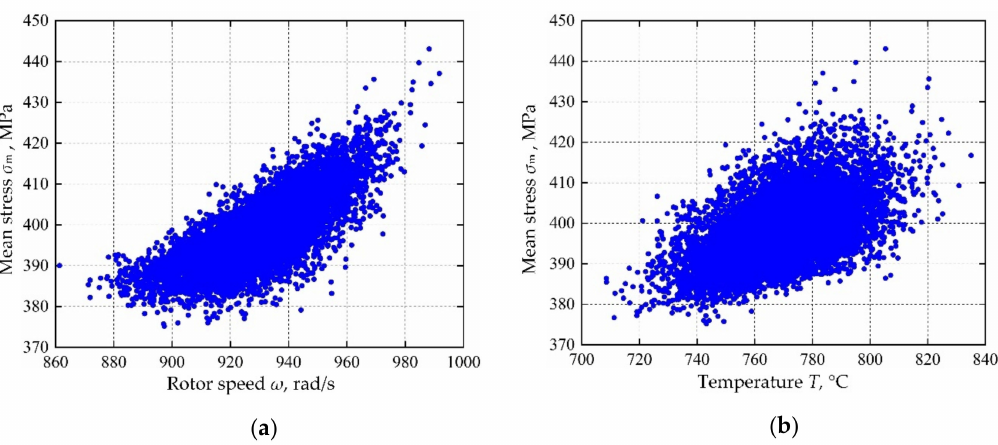
Figure 14. Scatter sketches of mean stress: ( a ) rotor speed, ( b )